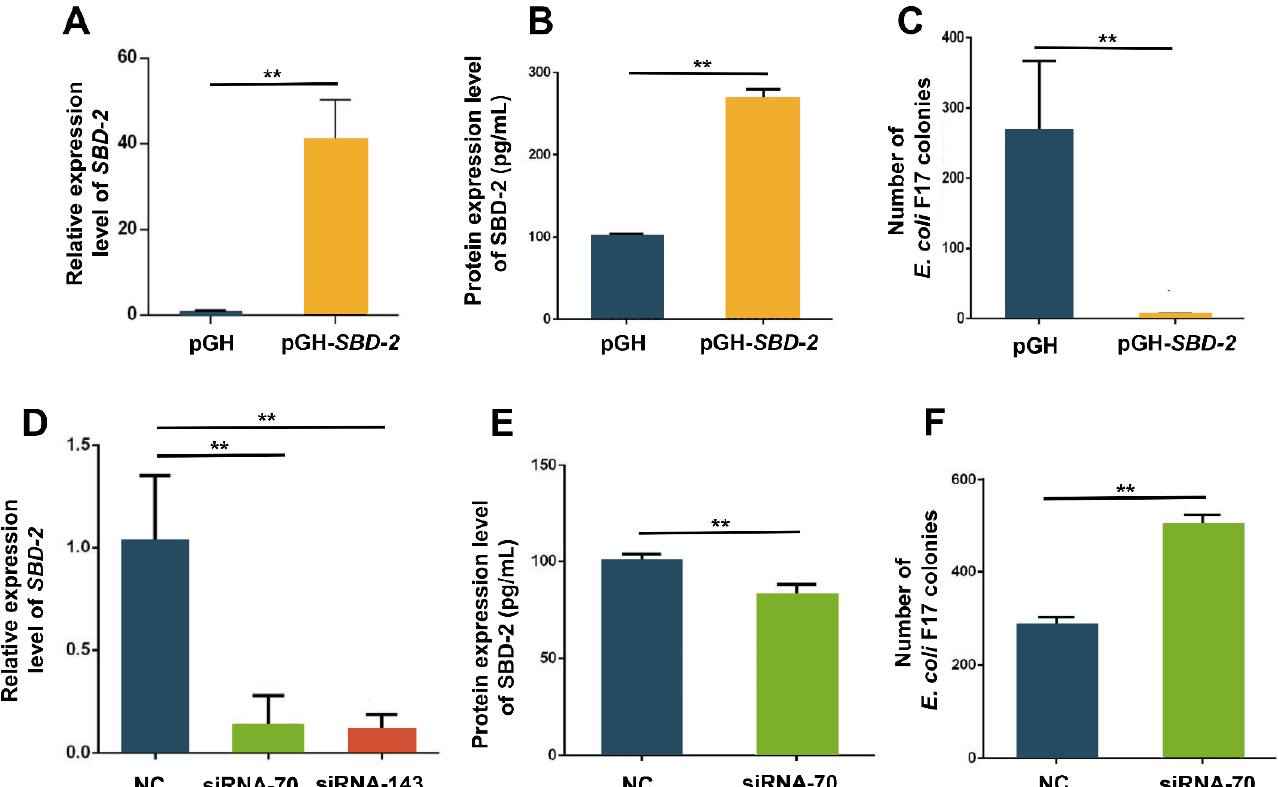
Figure 2. The effect of SBD-2 expression on the adhesion of E. coli F17 to OIECs. ( A ) Overexpression efficiency of SBD-2 mRNA expression level detected by RT-PCR in pGH (Control) cells and pGH-SBD-2 cells. ( B ) Overexpression efficiency of SBD-2 protein expression level detected by ELISA in pGH (Control) cells and pGH-SBD-2 cells. ( C ) Adhesion of the F17 fimbria to OIECs transfected with pGH-SBD-2 compared with pGH (Control) analyzed by bacteria enumeration. ( D ) Interference efficiency of SBD -2 mRNA expression level detected by RT-PCR in OIECs transfected with siRNA-SBD-2 compared with negative control. ( E ) Interference efficiency of SBD-2 protein expression level detected by ELISA in OIECs transfected with siRNA-SBD-2 compared with negative control. ( F ) Adhesion of the F17 fimbria to OIECs transfected with siRNA-SBD-2 compared with negative control analyzed by bacteria enumeration. ** p < 0.01, extremely significant difference; NS = no difference. Data were shown as mean ± SD, n = 3 biological replicates.